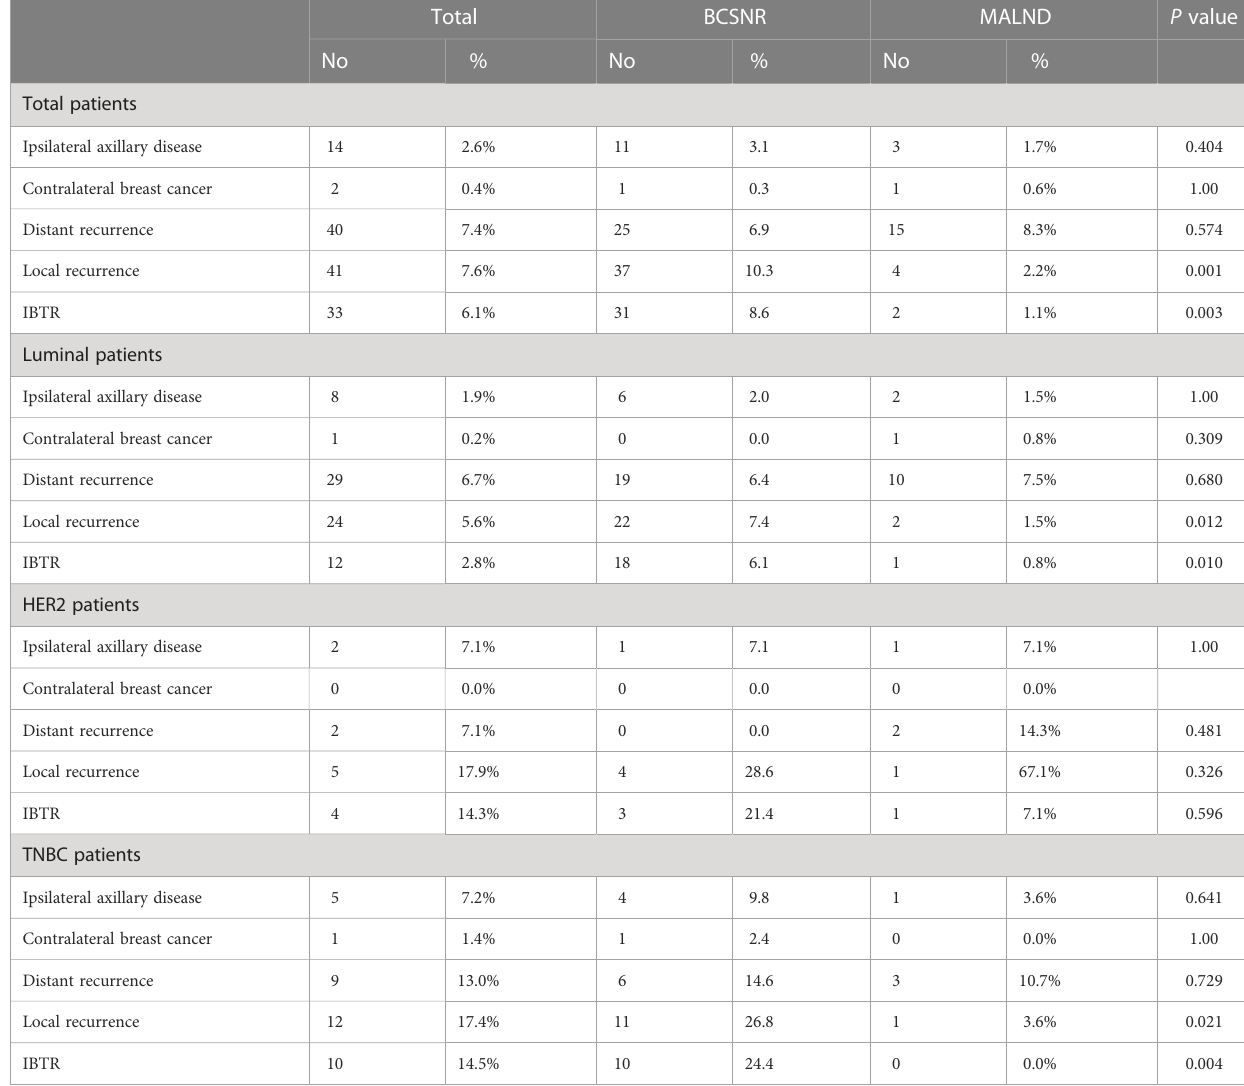
TABLE 2 Distant recurrence, Local recurrence and IBTR according to operation